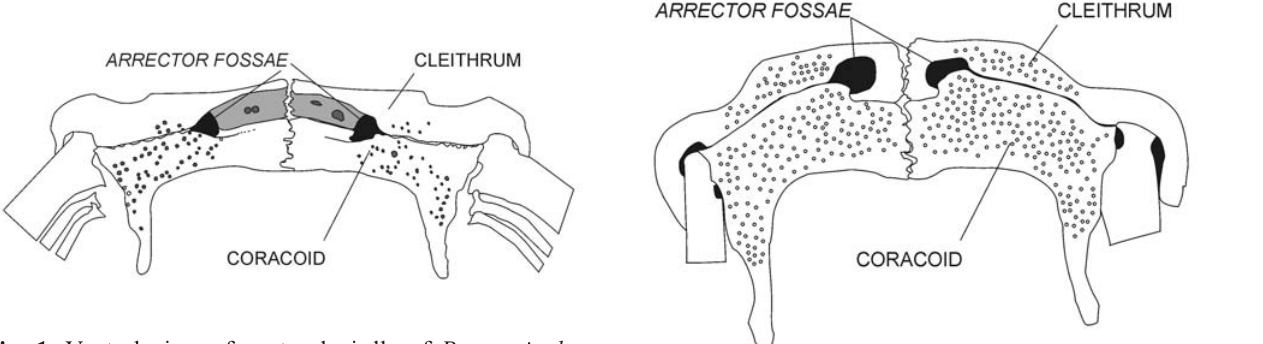
Fig. 1. Ventral view of pectoral girdle of Parotocinclus muriaensis , MNRJ 14753, c&s, 27.3 mm SL. Gray = cleithral roof of arrector fossae .